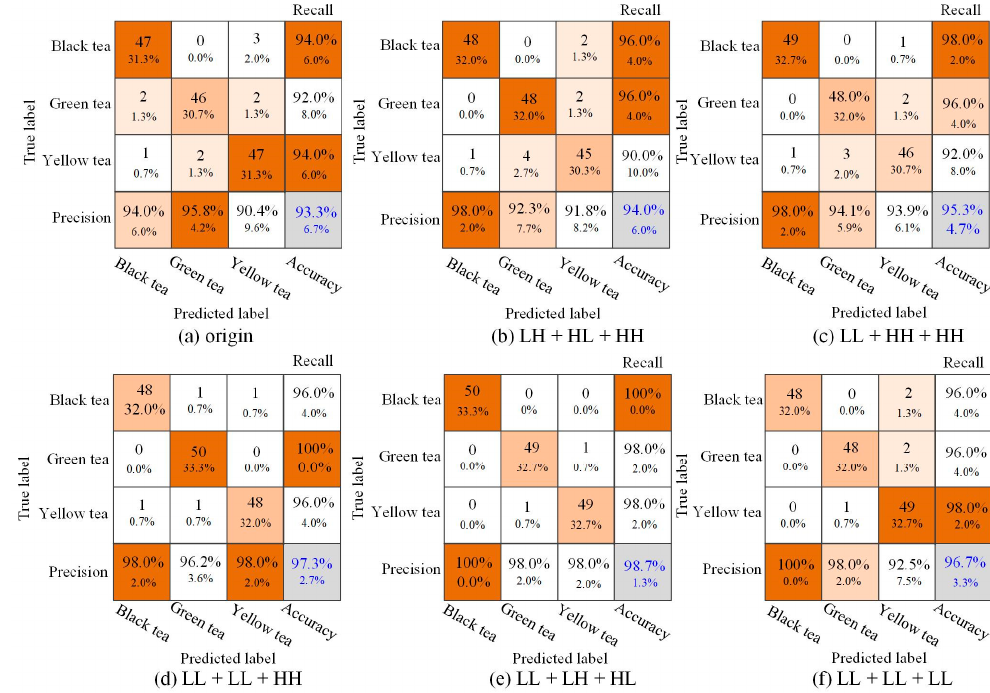
Figure 7. Confusion matrix of tea classification based on different components.